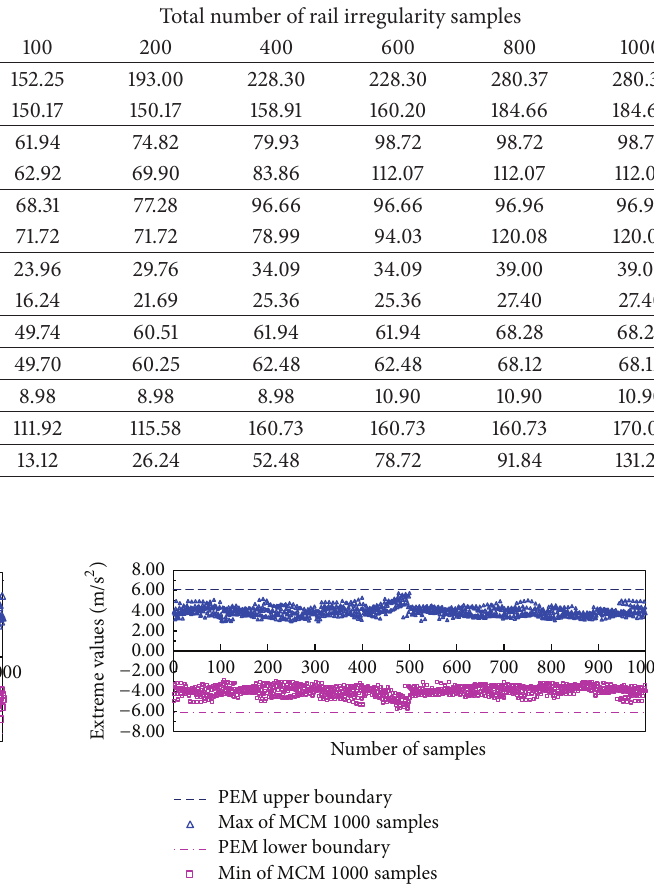
Table 5: The variation ratio VR